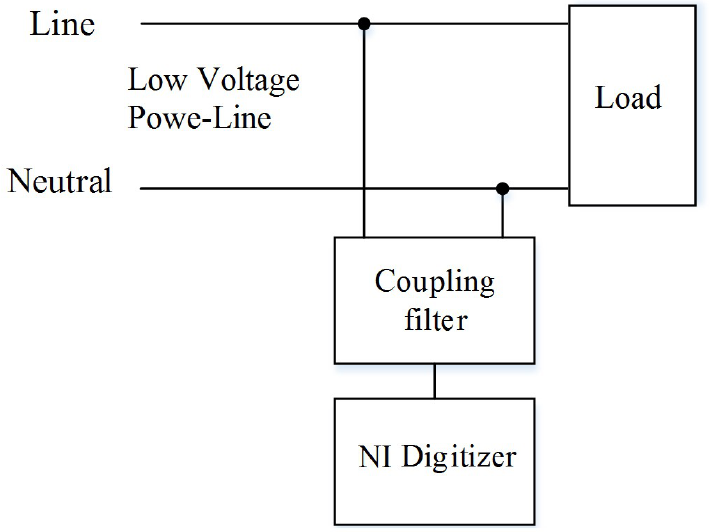
Figure 1. Measurement setup for noise collection.